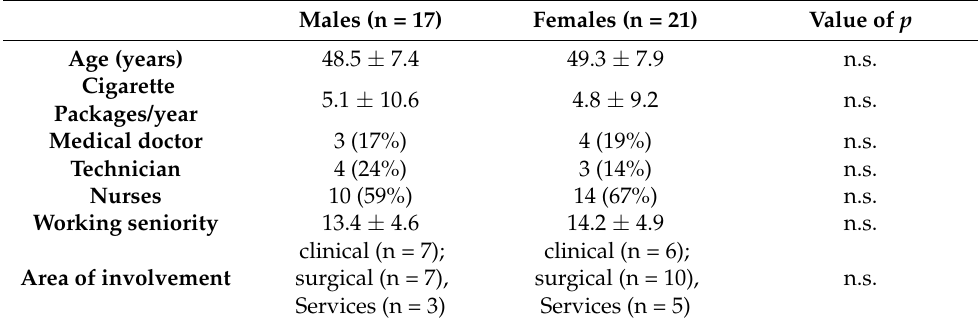
Figure 2. Flowchart of the sample studied illustrating in/excluded studies. The study sample of 38 HCWs (100%) included 45% (n = 17) male HCWs. Male and female groups were homogeneous, all of them worked shifts on all three shifts (see Tables 1 and 2). Table 1. Features of the sample at T0, divided by